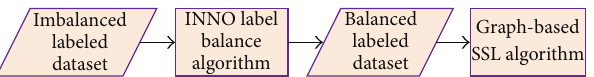
Figure 2: Workflow of graph-based SSL integrating with INNO.